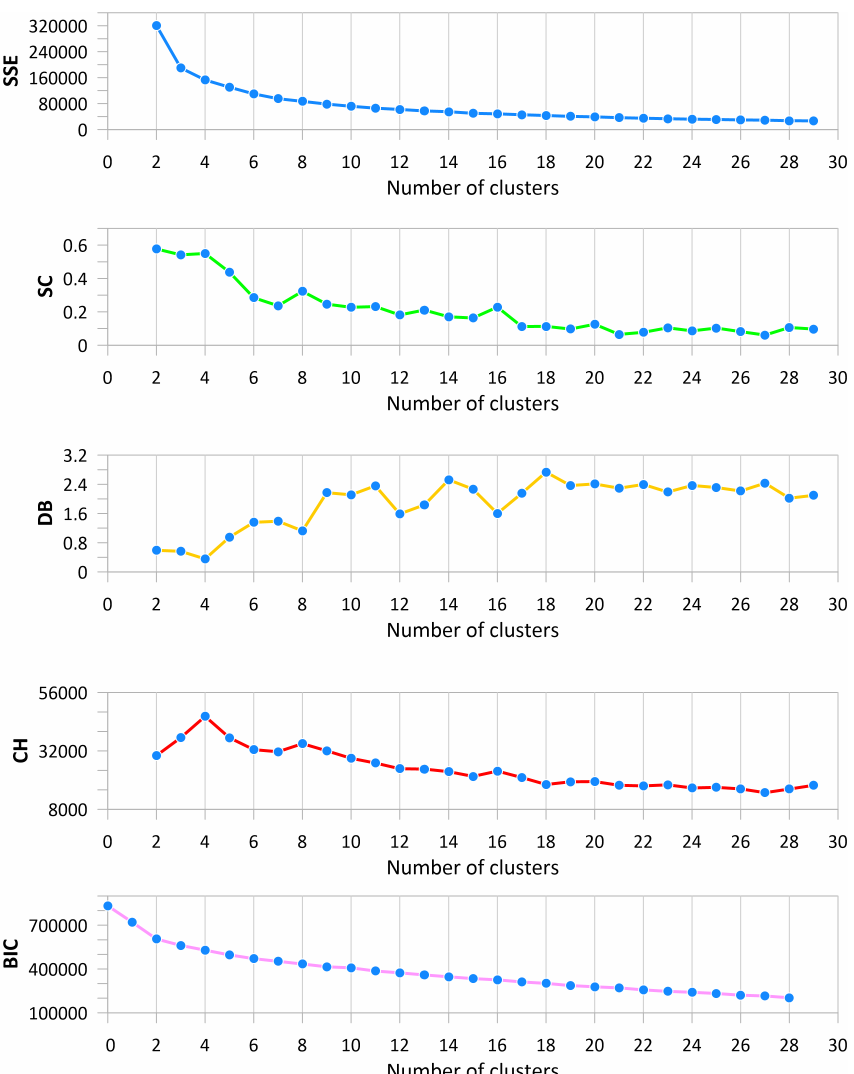
Figure 5. Metrics for cluster number validation for sonic log resolution dataset (inertia analysis— SSE—blue line; silhouette coefficient—SC—green line; Davies–Bouldin index—DB—yellow line; Calinski–Harabasz Index—CH—red line; Bayesian information criterion—BIC—pink